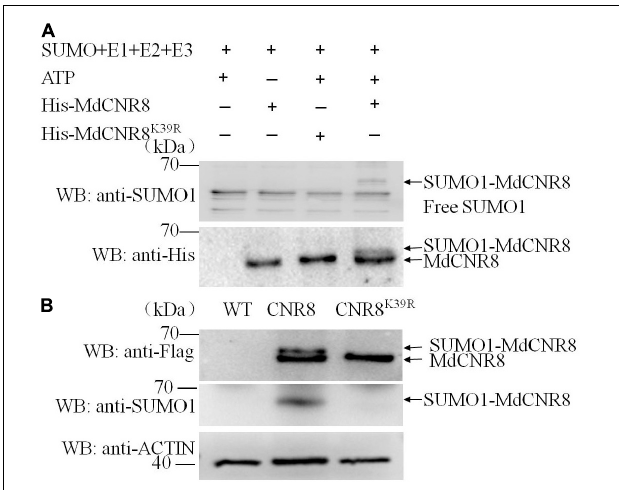
FIGURE 4 | MdCNR8 can be sumoylated in vivo and in vitro and Lysine 39 is an essential SUMOylation site. (A) Detection of SUMO1-MdCNR8 conjugates in vitro . SUMO1-MdCNR8 conjugates were detected in the presence (+) or absence (–) of ATP, MdCNR8 or MdCNR8 K39R with anti-His and an anti-SUMO1 antibodies. (B) Detection of SUMO1-MdCNR8 conjugates in vivo . The proteins from WT, MdCNR8-FLAG, and MdCNR8 K39R -FLAG calli were immunoprecipitated with anti-FLAG antibody. The proteins were detected with anti-FLAG antibody and anti-SUMO1 antibody. ACTIN was used as a